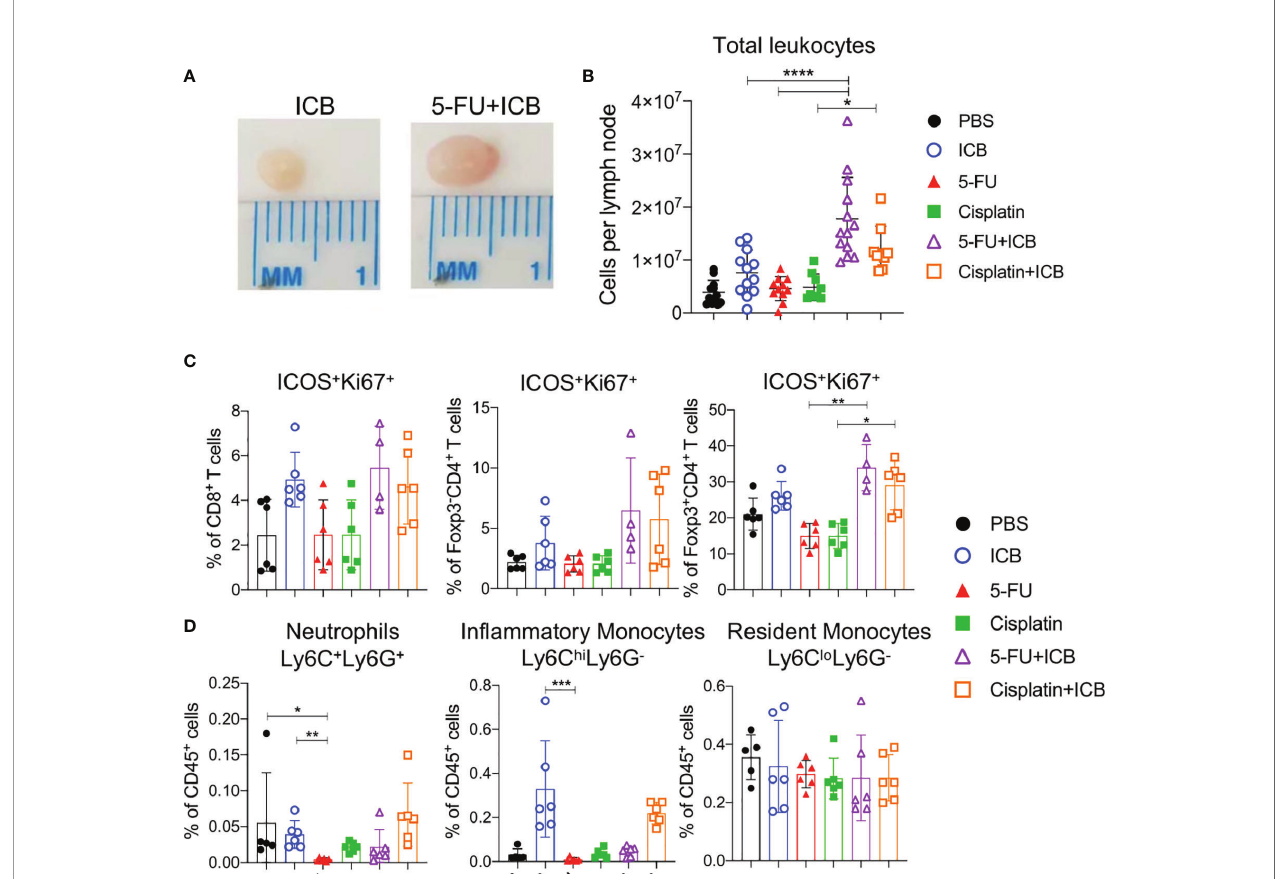
FIGURE 2 | 5-FU and cisplatin chemotherapy in combination with ICB causes expansion of T cells in tumor draining lymph nodes. (A) Representative images of tumor draining lymph nodes from AB1 tumor bearing mice after ICB (left) or 5-FU+ICB (right). (B) Absolute numbers of leukocytes, (C) proportions of activated (ICOS + Ki67 + ) CD8 + , CD4 + Foxp3 - (helper) and CD4 + Foxp3 + (regulatory; T regs ) T cells, and (D) proportions of neutrophils (CD11b + Ly6C + Ly6G + ), in fl ammatory monocytes (CD11b + Ly6C hi Ly6G - ), resident monocytes (CD11b + Ly6C lo Ly6G - ) in DLNs of different treatment groups. Data represented as mean ± SD, summary of three independent experiments. Mann-Whitney U test corrected for multiple comparisons; *P < 0.05, **P ≤ 0.01, ***P ≤ 0.001, ****P ≤